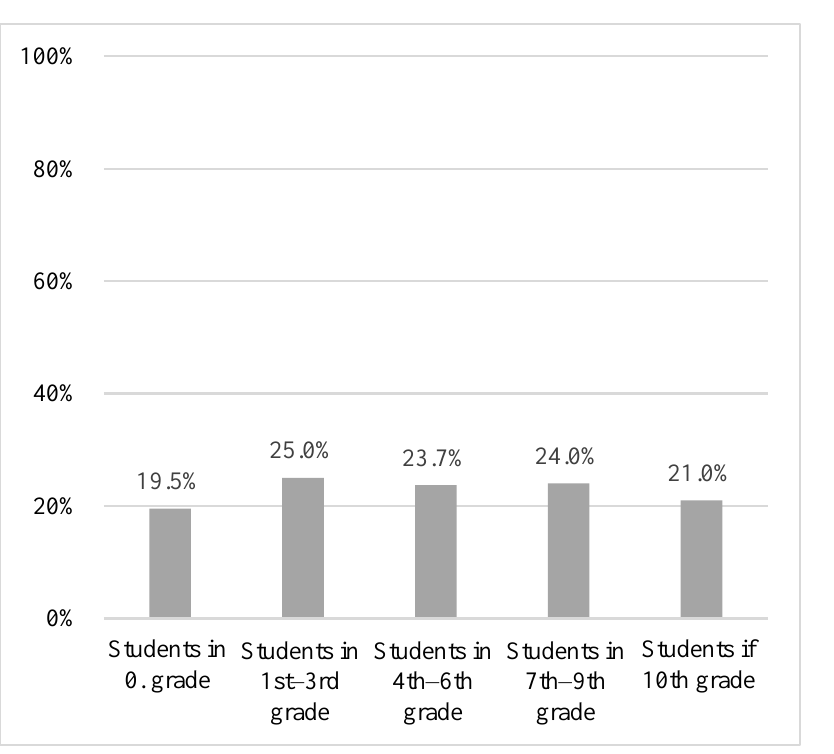
Figure 3. Proportion of participants feeling able to include students with diabetes during a school day . 3.2. Individualized Diabetes Plan The respondents indicated that 61.7% of schools had an action plan in case of hypo- glycemia, and 78.5% of schools had one or more personnel present at the school to support the students in diabetes management (Table 3) (Table A1). 3.3. Education and Knowledge The respondents indicated that the school personnel had received diabetes specific training at 77.2% of the schools. However, the respondents reported to have inadequate knowledge on acute situations (49.0%), blood sugar levels (57.7%), impact of physical ac- tivity (56.0%), administration of glucagon (22.4%), when to call the emergency services